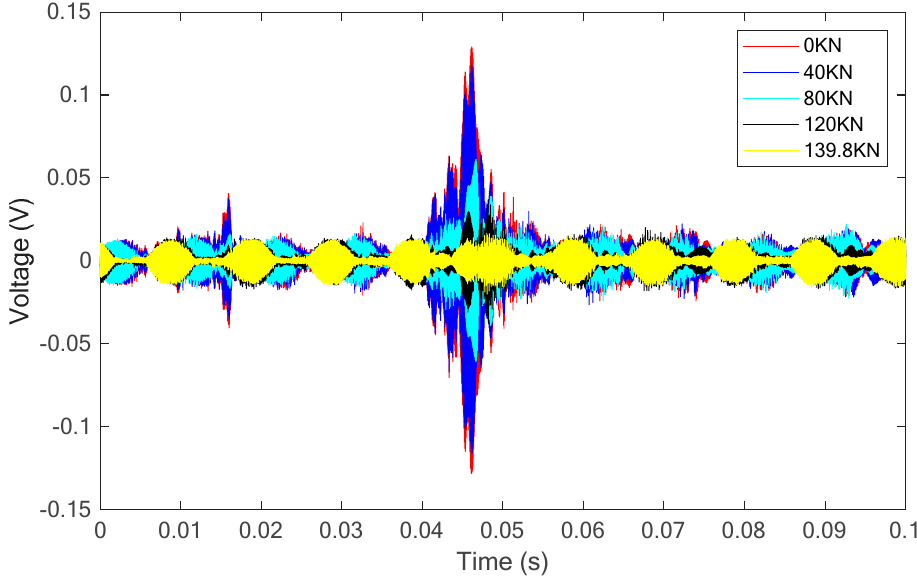
Figure 20. The received signals of the sensor for the specimen with the SCFRP strengthening.